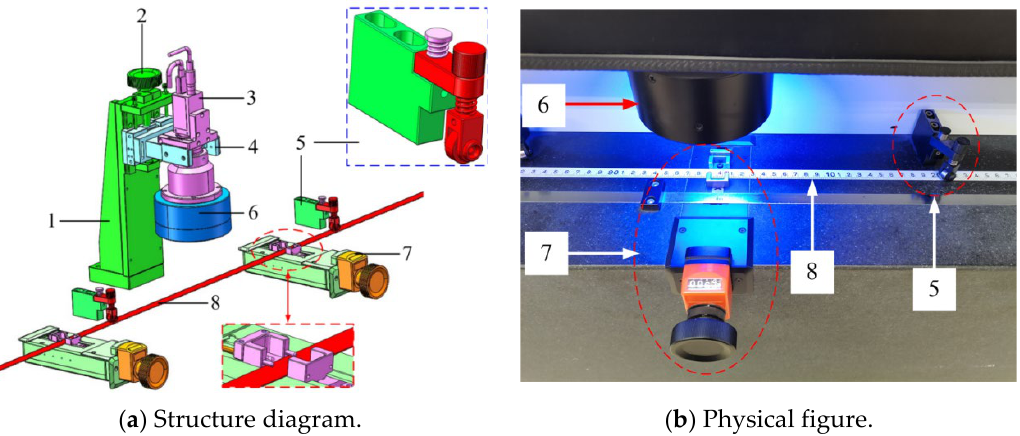
Figure 4. Machine vision system: 1. Fixed part; 2. manual focus knob; 3. industrial camera (CCD camera); 4. mounting base; 5. tape pressing device; 6. diffuse light source; 7. tape belt limit mecha- nism; 8. steel